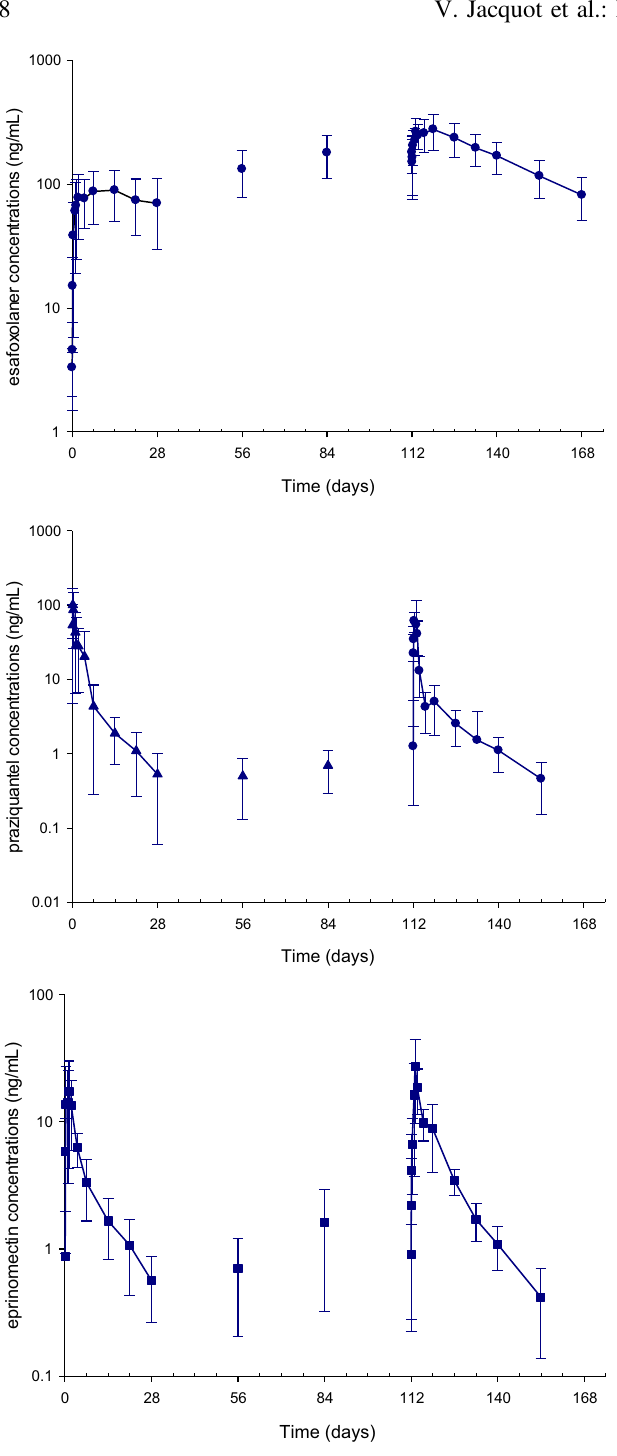
Figure 5. Mean plasma concentrations of esafoxolaner, praziquantel and eprinomectin after fi ve topical administrations of NexGard (cid:1) Combo at 4-week